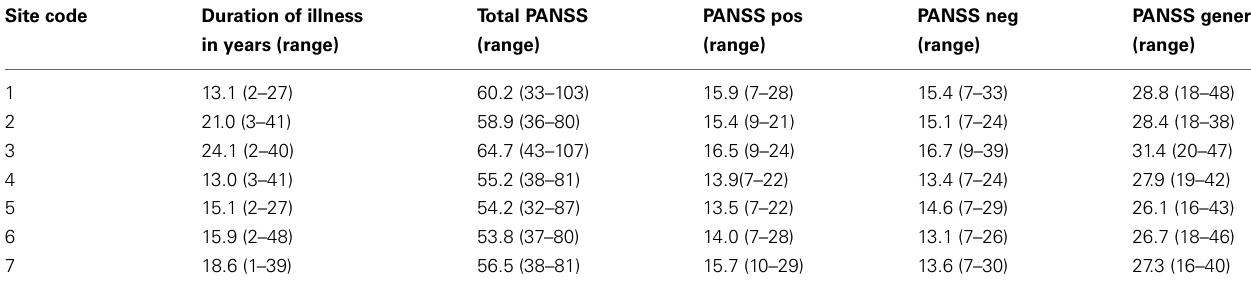
Table 2 | Disease duration, PANSS total, positive, negative, and general scores by mean (range). Site